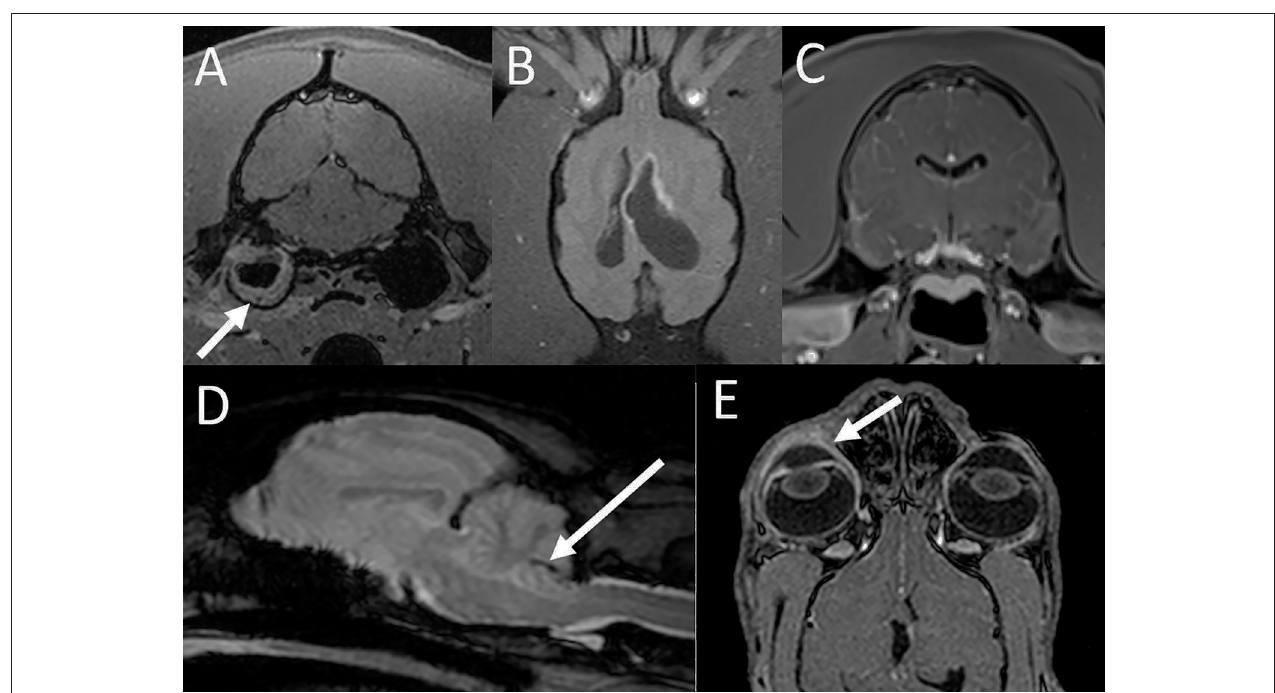
FIGURE 3 | MRI findings with inflammatory conditions. (A) Otitis media and interna in a tiger. The transverse post contrast T1-W GRE image with FatSat (“VIBE”) shows soft tissue material along the periphery of the right tympanic bulla (arrow). There is also mild contrast enhancement of the soft tissues adjacent to the bulla consistent with regional inflammation. (B) Intracranial blastomycosis in a tiger. On the dorsal T1-W FatSat image there is asymmetric dilatation of the lateral ventricles with marked contrast enhancement of the ventricular lining especially along the rostral horn of the left lateral ventricle. (C) Lymphoplasmacytic meningoencephalitis in a tiger. On the transverse post contrast T1-W GRE image with FatSat (“VIBE”) there is evidence of marked mostly leptomeningeal contrast enhancement. (D) Parasitic meningoencephalitis in a bobcat. A linear susceptibility artifact is associated with the cerebellum (arrow), consistent with a hemorrhagic migration tract. (E) Corneal ulcer, keratitis and uveitis in a lynx. The dorsal post contrast T1-W GRE image with FatSat (“VIBE”) shows contrast enhancement of the right cornea and uvea (arrow) compared to the